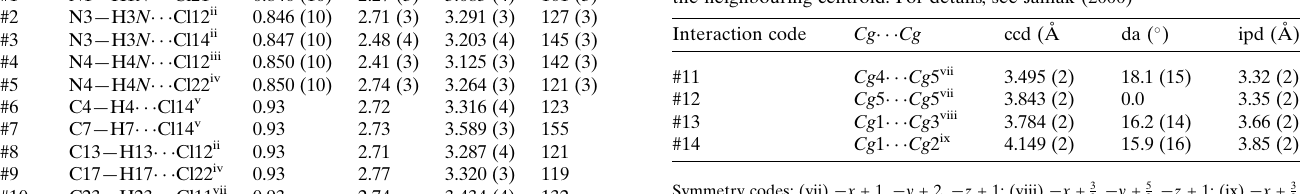
Table 1 Hydrogen-bond geometry (A˚ , (cid:5) ) for (I). Code